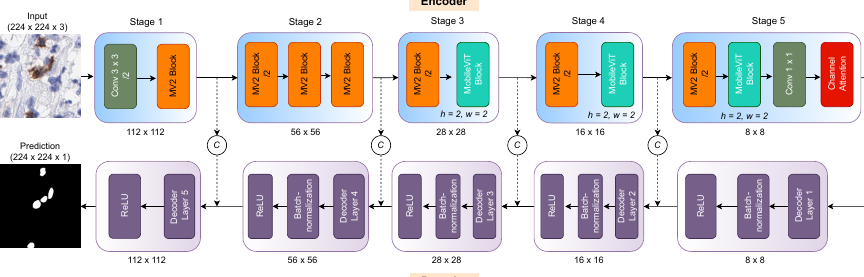
Figure 2. Overview of proposed segmentation model. The input IHC patch image feed to the encoder layer that extracts the spatial and global feature information. The decoder reconstructs the features into the segmentation map. Where C refers to the feature concatenation. The dash (- -) line corresponds to the skip connection between each encoder and decoder